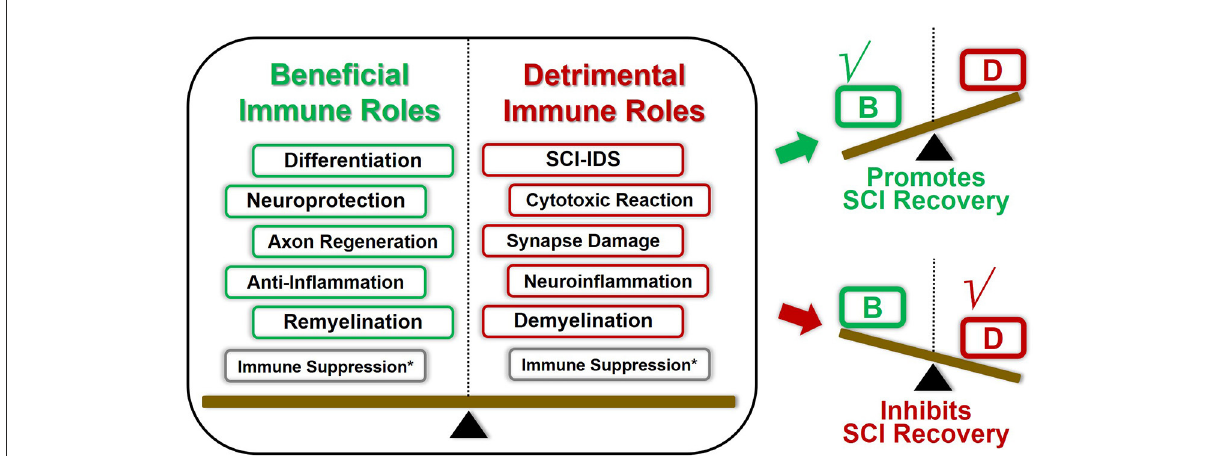
FIGURE4 Double-edged immune factors modulate the overall immune landscape SCI recovery. Most of these aforementioned immune factors played both beneficial and harmful roles in regulating SCI pathological repair process. The overall outcomes of SCI pathological repair are the superimposed results of multiple immune elements. For instance, once the beneficial immune roles overcome these detrimental counterparts under certain conditions, the overall immunomodulation tent to promote SCI repair, and vice versa. Consequently, coordinating the panoramic immune landscape of SCI pathophysiological changes will provide us deepening understanding of how immune factors modulate the SCI recovery process. *The immunosuppression effects could be both beneficial and detrimental toward SCI recovery, which presents various characteristics due to the spatiotemporal